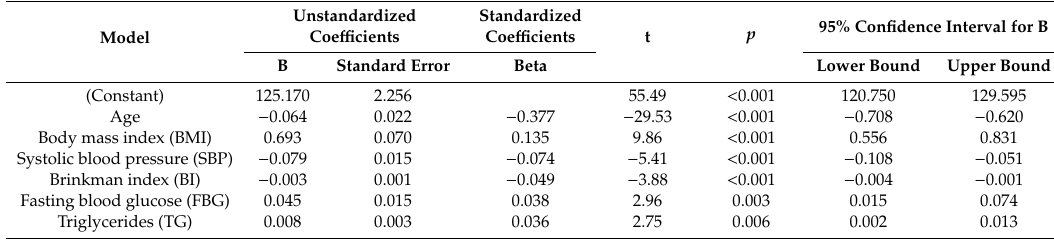
Table 4. Multiple linear regression analysis for white matter hyperintensity brain healthcare quotients (WMH-BHQ) risk factors.